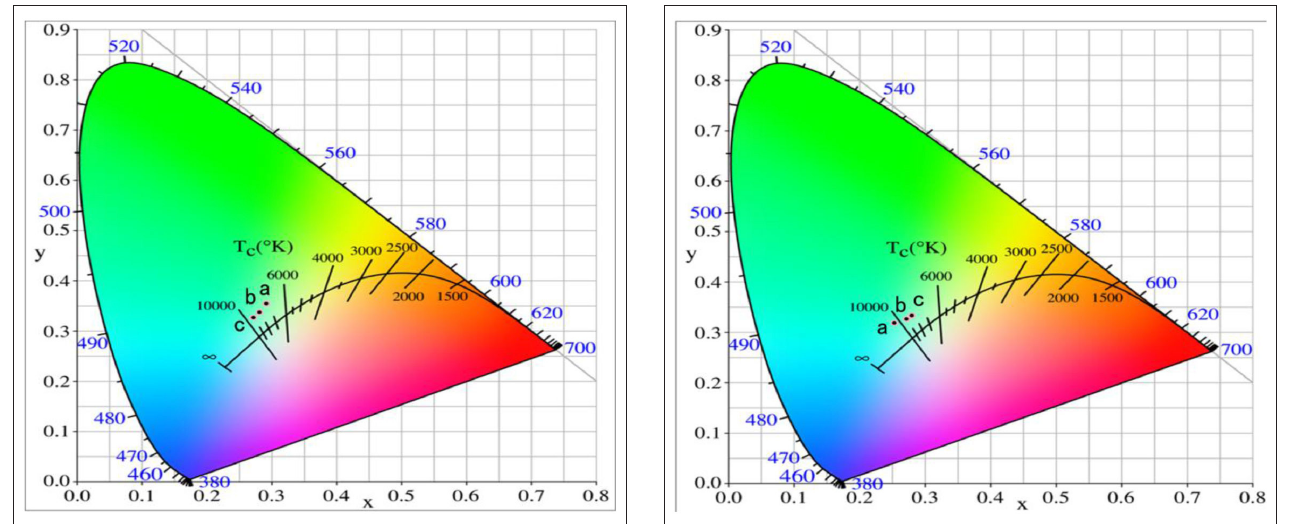
FIGURE 5 | Chromaticity coordinate of the GdAlO 3 : 0.6%Er 3 + , y%Yb 3 + , 1%Tm 3 + phosphors under 980nm excitation (a: y = 12, b: y = 14, c: y = 16).